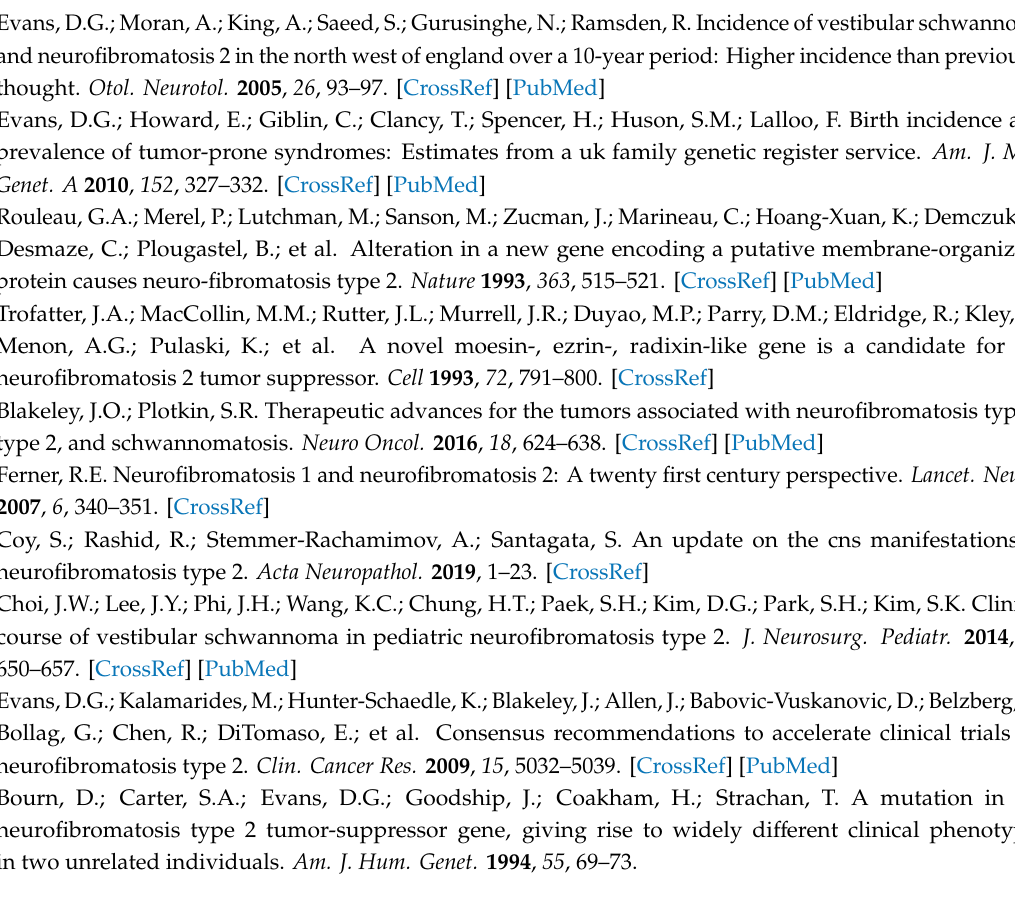
Table S1: Individual characteristics of patients with NF2 before matching. CNS = central nervous system; F-G = the Feiling–Gardner type; HS = hypoglossal schwannoma; JS = jugular foramen schwannoma; MGM = meningioma; NF2 = neurofibromatosis type 2; OS = oculomotor schwannoma; other S = other schwannoma; SS = spinal schwannoma; TS = trigeminal schwannoma; VS = vestibular schwannoma; W = the Wishart type. Table S2. Hearing results on the basis of pre-SRS PTA before matching. SRS = stereotactic radiosurgery; PTA = pure-tone average; NF2 = neurofibromatosis type 2; VS = vestibular schwannoma. Table S3. Hearing results on the basis of pre-SRS PTA in the propensity score-matched